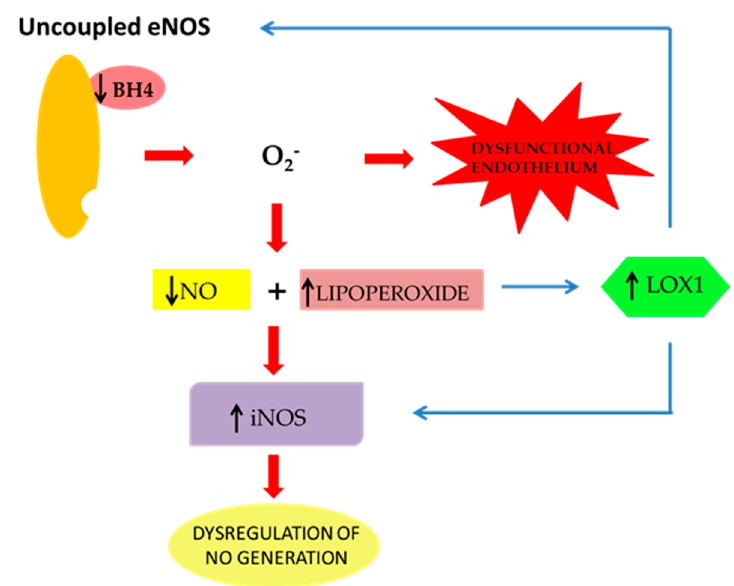
Figure 1. Basis for the correlation between dysregulation of eNOS / iNOS enzymes. Uncoupled eNOS is unable to produce NO and generates superoxide anions. The reduction in NO levels and the increase in lipoperoxides upregulate iNOS activity. In this context, lipoperoxide increase causes an enhanced expression of LOX-1 and, consequently, a further dysregulation of NO production.